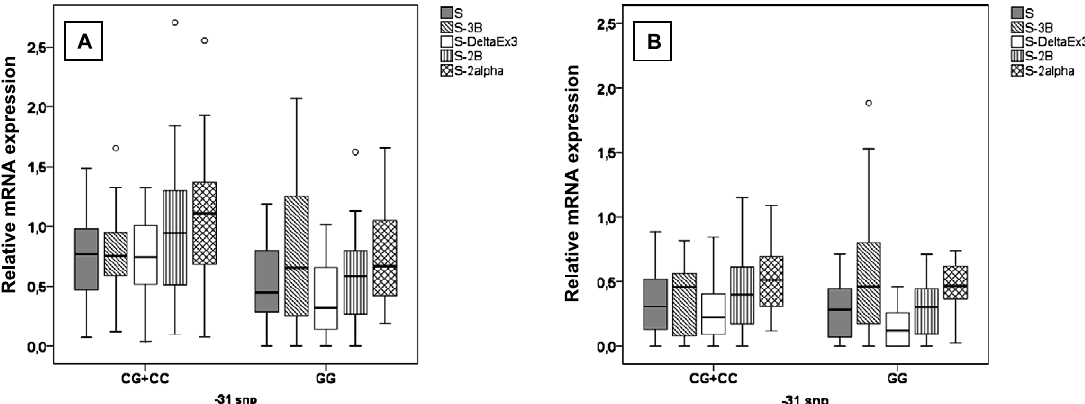
Fig. 4. Relationship between expression levels of survivin splice variants and − 31 genotype. S – survivin, A – neoplastic tissue, B – normal tissue.